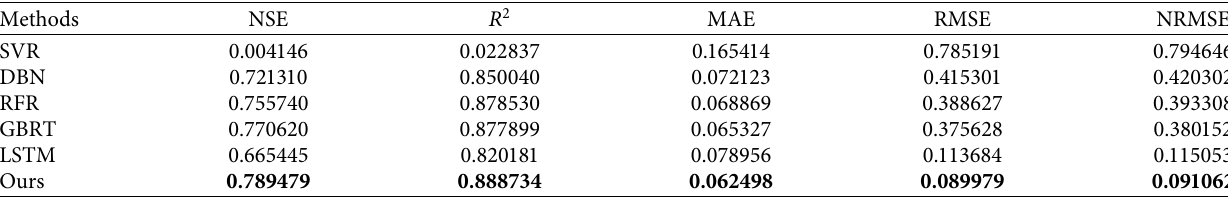
Table 2: Evaluation results for lead time of 12h.